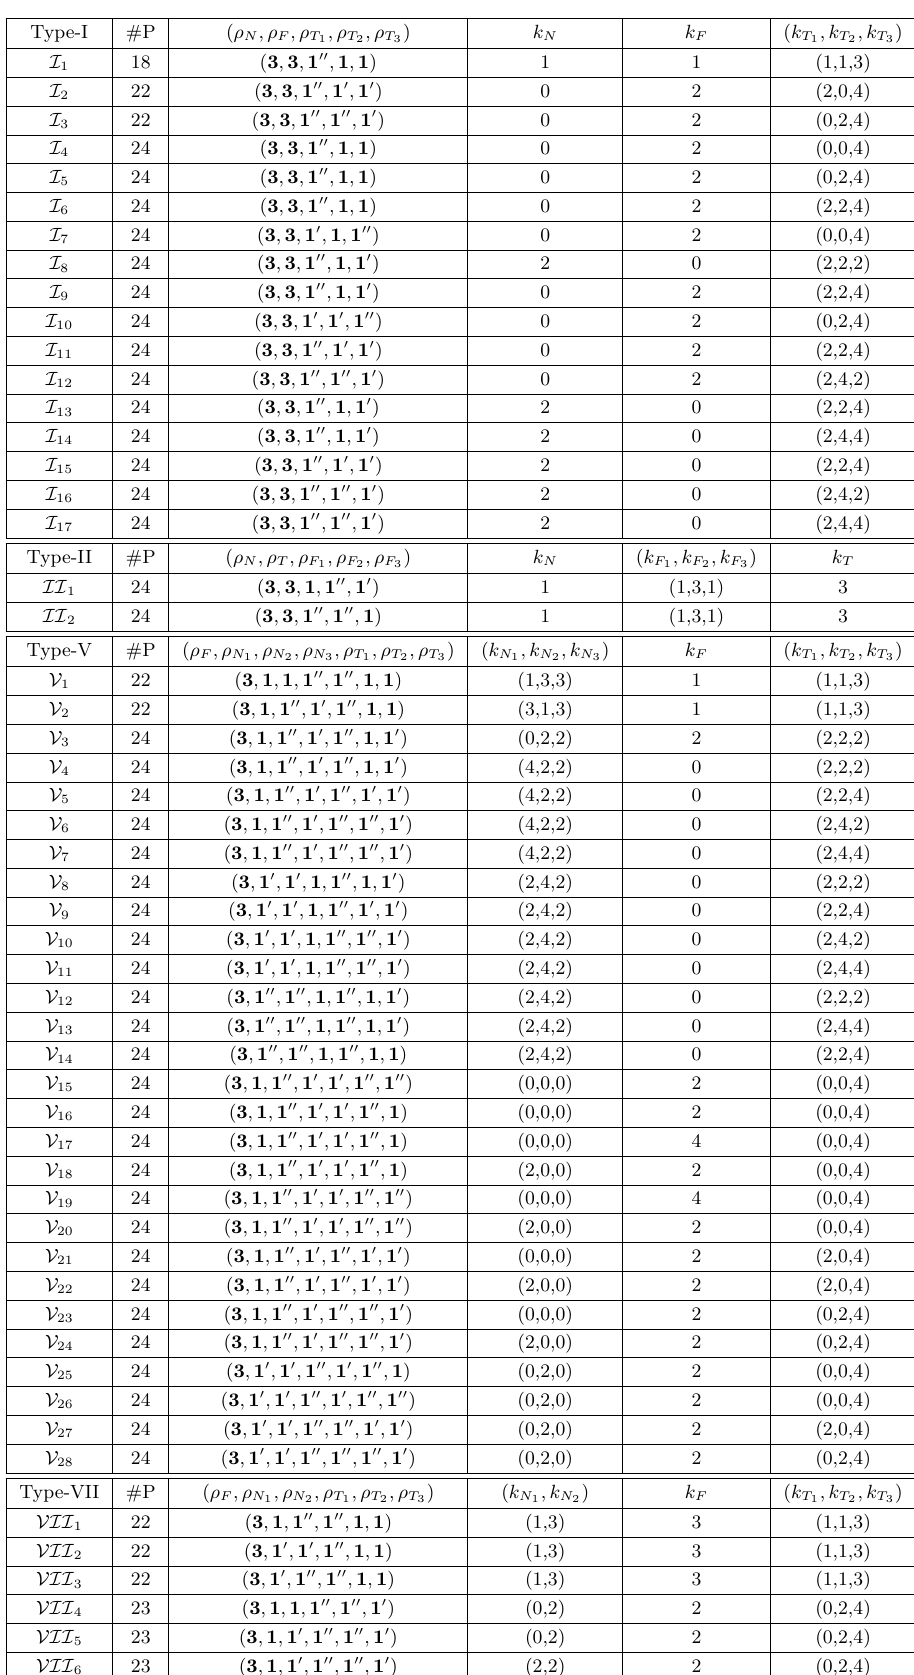
Table 2 . Summary of phenomenologically viable SU(5) GUT models based on A 4 modular symme- try with less free parameters. Here the real and imaginary part of τ are taken as free